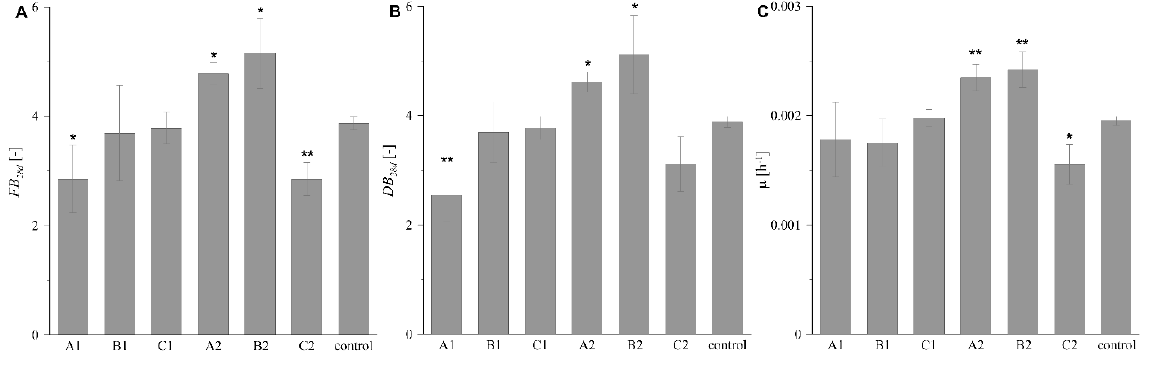
Figure 6. Values of FB 28d ( A ), DB 28d ( B ), and µ ( C ) quantitatively identify the proliferation of R. graeca hairy roots in culture systems varying in the form of supporting MTMS-based gel and in the control culture without any MTMS-based material. Following materials were investigated: (A1) disintegrated mesoporous xerogel, (B1) disintegrated macroporous xerogel, (C1) aggregated precipitate of MTMS, (A2) PP-reinforced mesoporous xerogel, (B2) PP-reinforced microporous xerogel, (C2) PP fibers with a deposited precipitate of MTMS. The asterisks mark the culture systems at which the determined values of the parameters were statistically different from the values identifying the reference culture with p < 0.05 (*) and p < 0.01 (**) according to the ANOVA test.